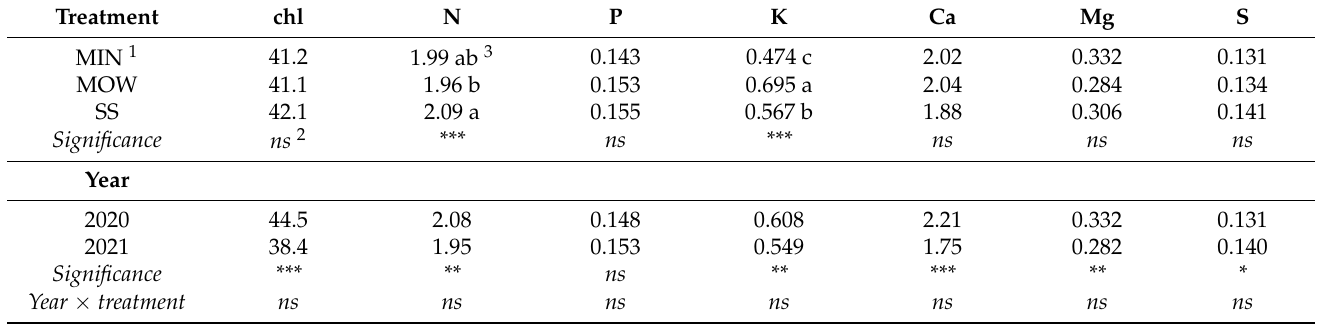
Table 3. Effect of fertilization treatment and year on leaf chlorophyll (chl) measured as SPAD unit and macronutrient concentration (g 100 g − 1 DW) in